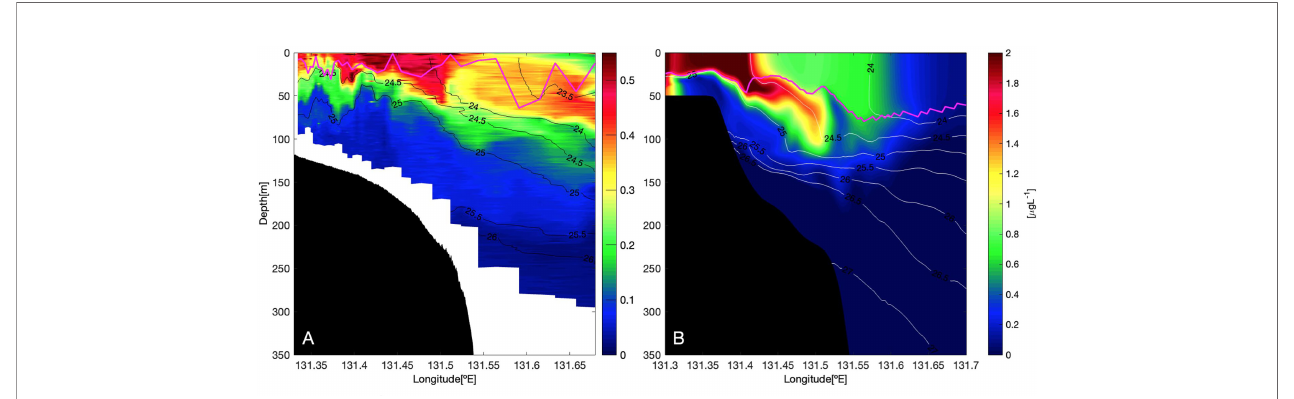
FIGURE 3 | Vertical sections, computed along the cyan line in Figure 1 , of chlorophyll-a concentration ( m g L -1 ) for (A) in-situ data taken onboard in November 2018 (Nagai et al., 2019), and for (B) ROMS numerical simulation on December 20 th at hour 18:00. The black and white contours in A and B, respectively, represent isopycnals and the magenta line represents the MLD.